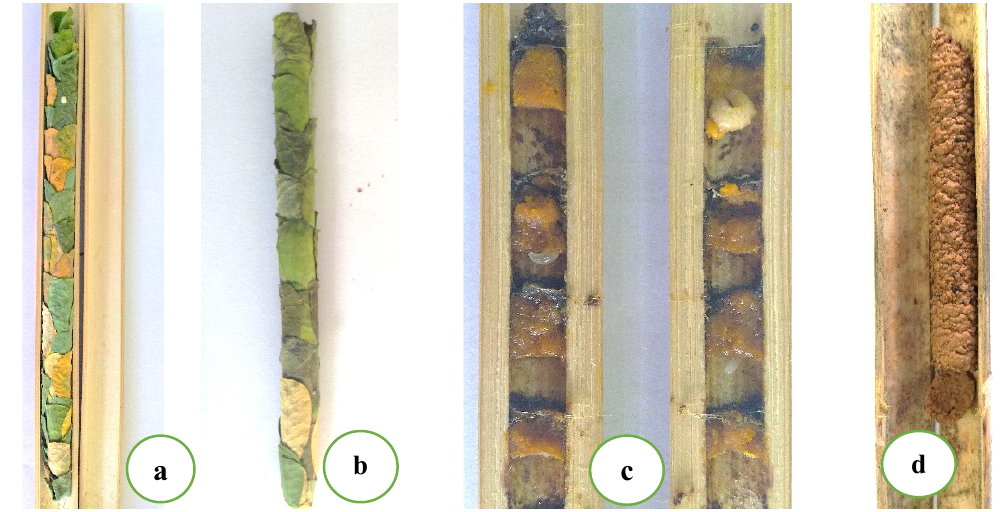
Fig 2 . Different types of nesting materials used by bees Megachile Latreille, 1982 in a Cajanus cajan (L.) Millsp. (Fabaceae) plantation of the experimental farm of ICAR-National Bureau of Agricultural Insect Resources (NBAIR) Bengaluru, Yelahanka Campus, India; a . and b . leaf bits c . resin d . mud. Trap nests had a significant influence on trap rate occupancy by bees during the crop vegetative and flowering stages (F value = 84.03; P < 0.0001) (Table 1). The